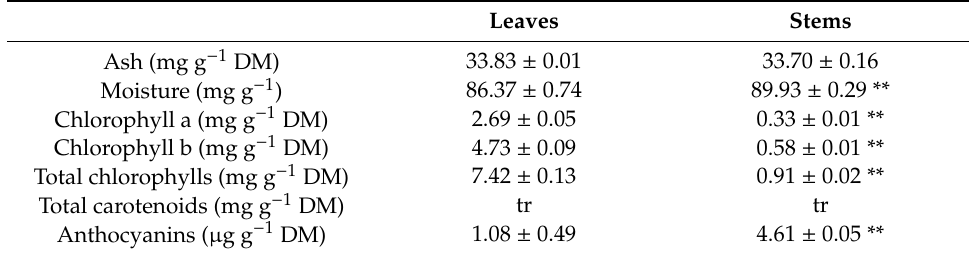
Mean composition of sampled P. oleracea from three replications ± standard deviation. Di ff erent symbols (**), for the same parameter, within columns indicate significant di ff erences (** p < 0.01) between the two aerial parts of the plant. tr: trace ( < 0.01 mg g − 1 DM).